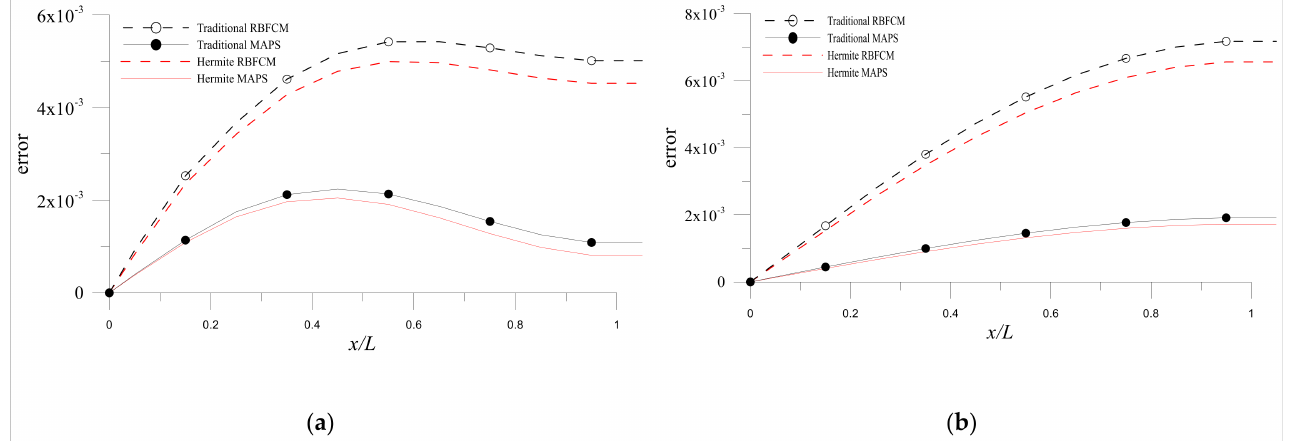
Figure 4. Errors of numerical solutions obtained by the four methods at ( a ) t = 5 and ( b ) t = 20 for Example